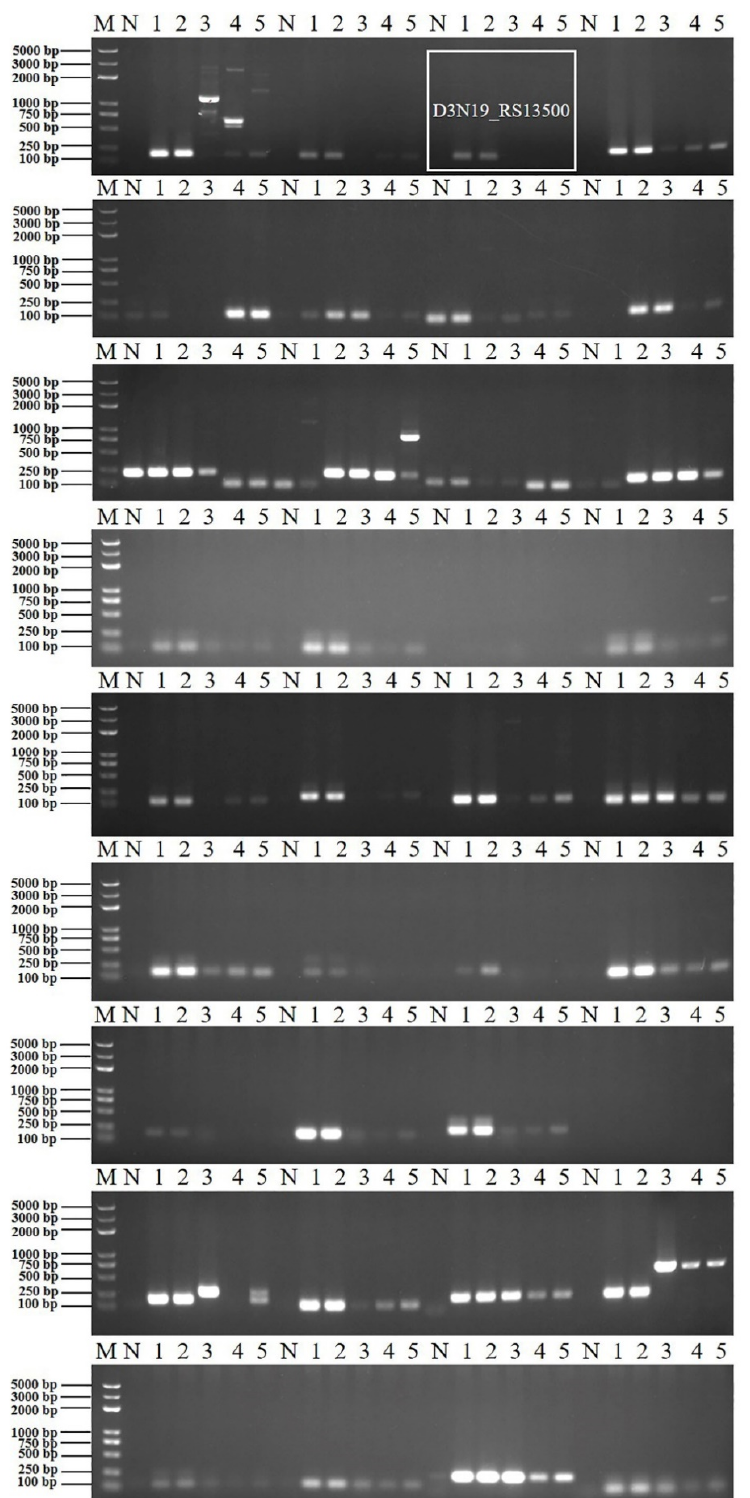
Figure 2. Specific primers targeting B. velezensis screening in different Bacillus strains. M, DNA marker (from large to small was 5000 bp, 3000 bp, 2000 bp, 1000 bp, 750 bp, 500 bp, 250 bp, 100 bp); N, negative control; 1, amplification template of B. velezensis ZF2 genomic DNA; 2, amplification template of B. velezensis ZF128 genomic DNA; 3, amplification template of B. velezensis FZB42 T genomic DNA; 4, amplification template of B. amyloliquefaciens DSM 7 T genomic DNA; 5, amplification template of B. subtilis 161 T genomic DNA.